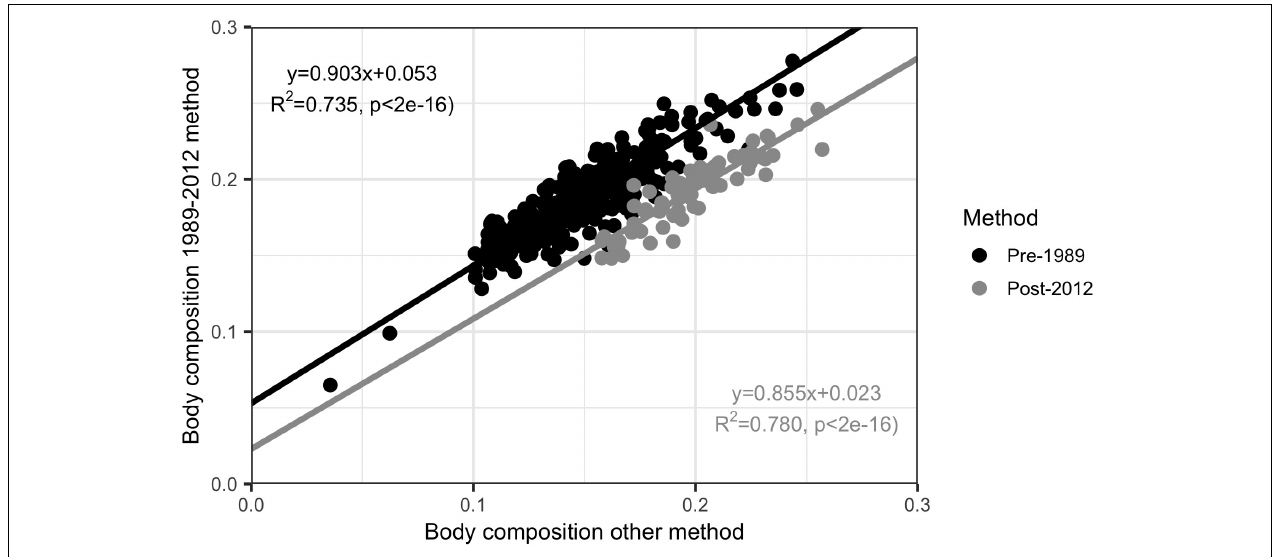
FIGURE 2 | Linear regression of pre-1989 ( n = 108) and post-2012 ( n = 80) body composition calculation methods against 1989–2012 method. Regression coefficients shown were used to correct data to body compositions from before and after the 1989 to 2012 time period to the 1989–2012